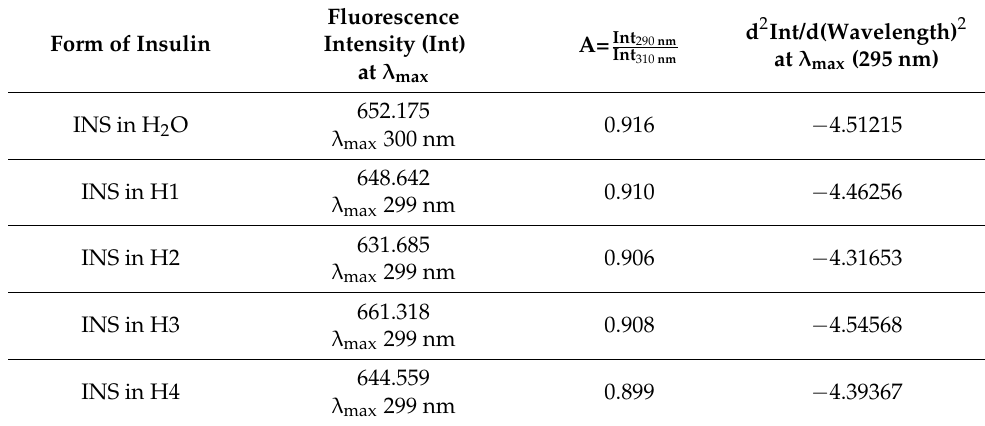
Figure 9. Emission fluorescence spectra of insulin at 1.04 × 10 − 5 g/cm 3 concentration both in H 2 O and in the presence of model hydrogels H1–H4, λ ex 276 nm. Table 8. Insulin fluorescence parameters both in H 2 O and in the presence of model hydrogels H1–H4 at λ ex 276 nm.